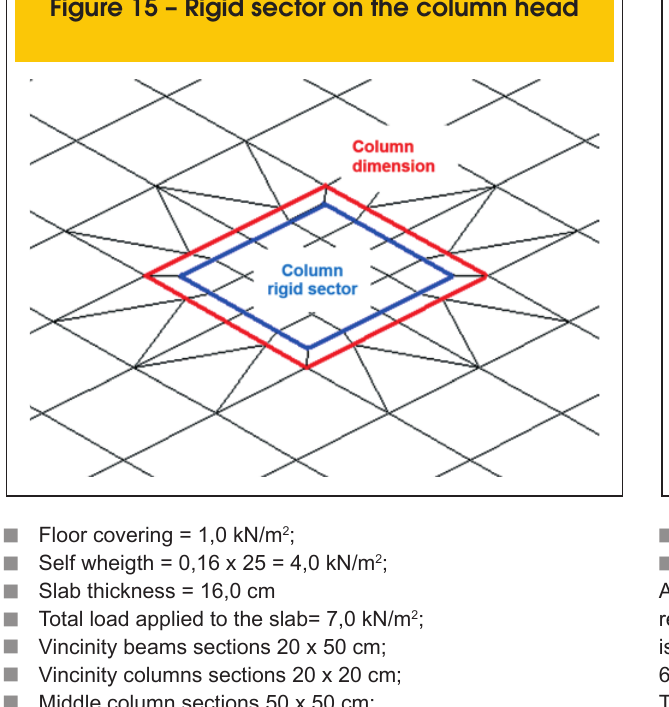
Figure 15 – Rigid sector on the column head